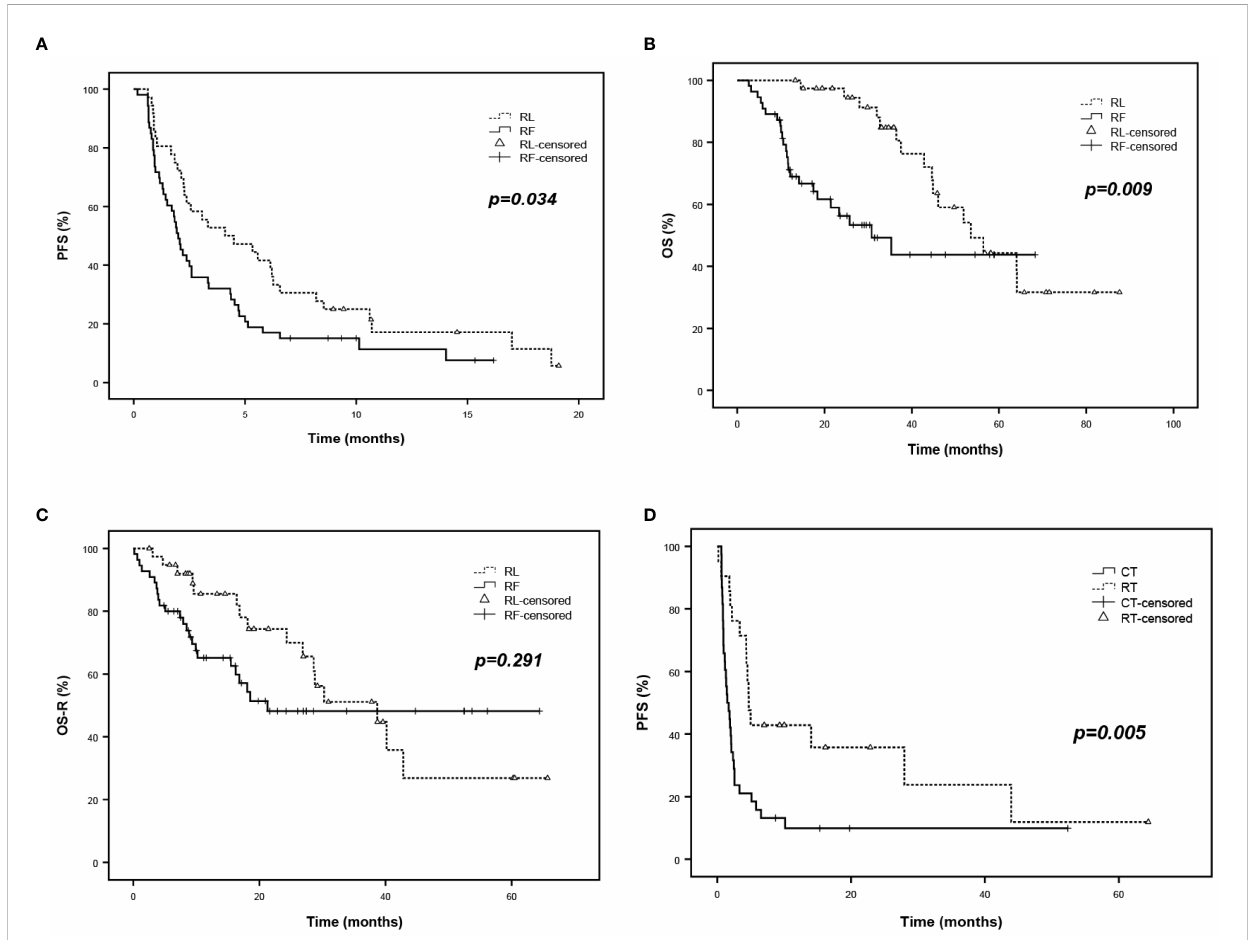
FIGURE 3 Survival analysis of R/R PCNSL. (A) PFS of R/R PCNSL patients after salvage treatment according to RL and RF group. (B) OS of R/R PCNSL patients according to RL and RF group. (C) OS-R (OS after salvage treatment) of R/R PCNSL patients according to RL and RF group. (D) PFS of refractory PCNSL patients after salvage treatment according to RT and CT subgroup.